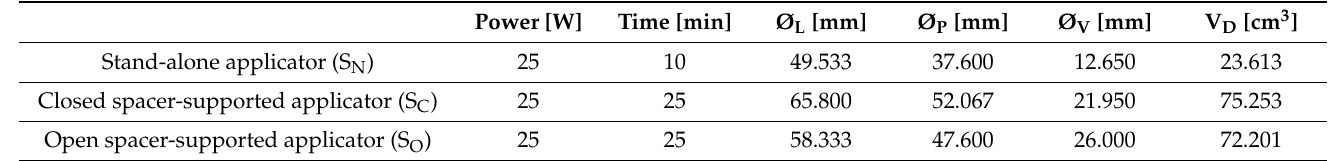
Table 2. Mean ablation diameter and volume are increased by use of a spacer (S C und S O ) in comparison to the stand-alone applicator (S N ). n =